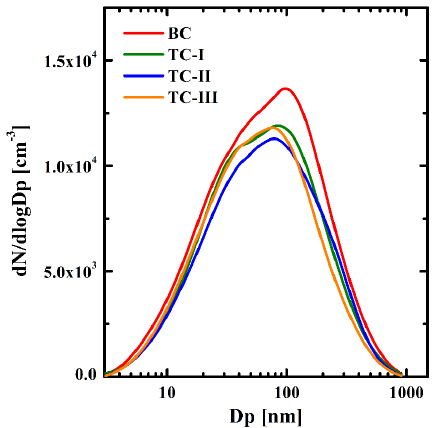
755 Fig. 2. Mean particle number size distributions in different control Figure 2: Mean particle number size distributions in different control stages corresponding to Table 1 756 stages corresponding to Table 1. 757 758